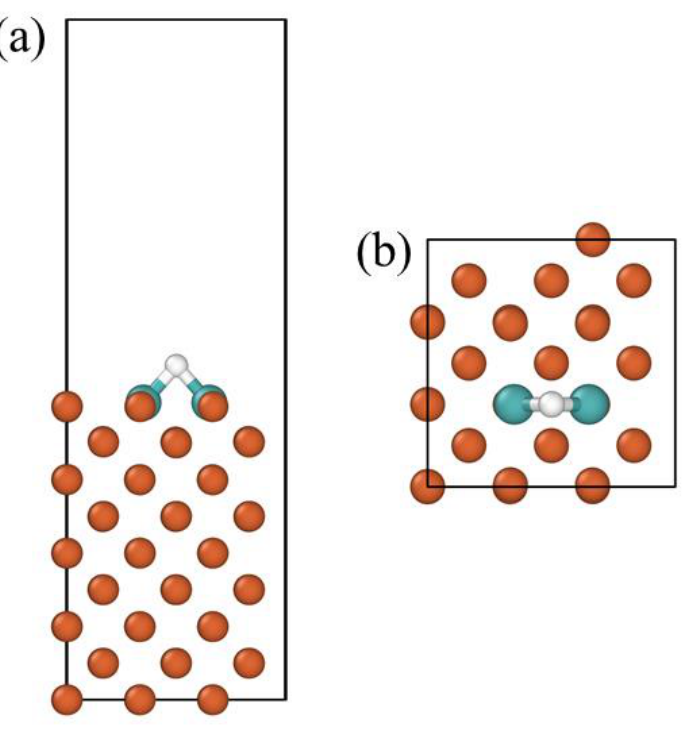
Figure 1. H adsorption sites on Mo-doped Fe (100) planes. ( a ) The front view, ( b ) The plan view. The green one is the Mo atom, the white one is the hydrogen atom, and the others are the Fe atom.